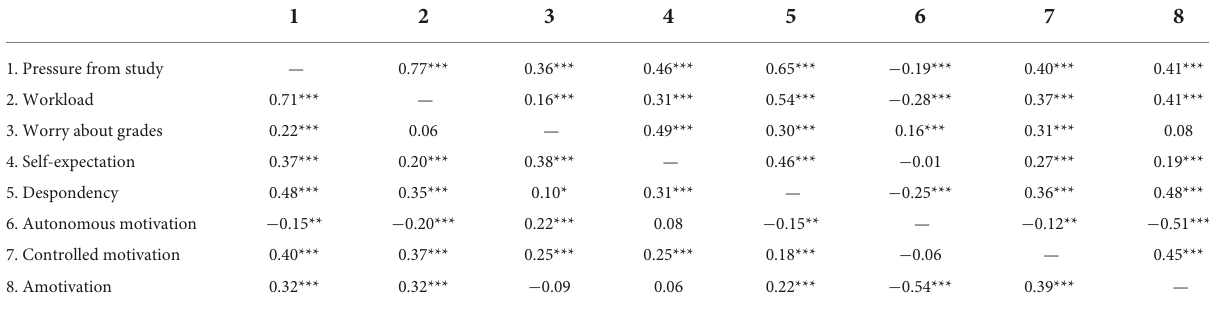
TABLE 3 Correlations among academic stress and motivation toward physical education (PE) (first collection below diagonal and second collection above